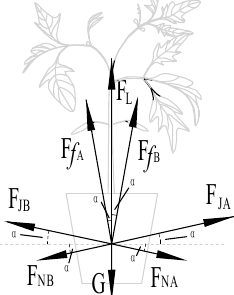
Figure 4. Force analysis of a seedling.